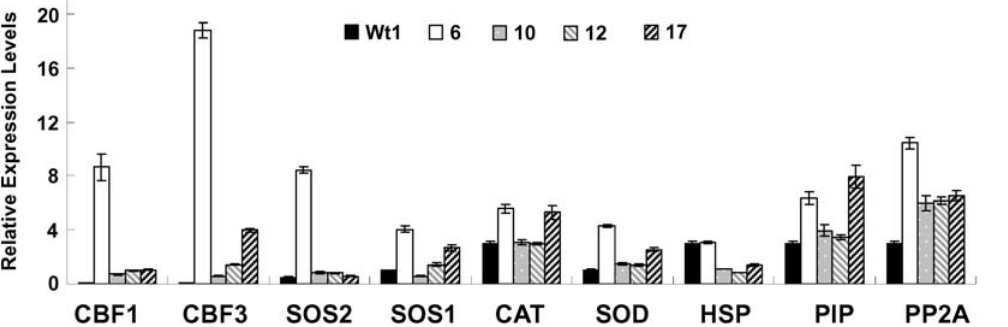
Figure 6. Quantitative RT-PCR analysis of relative expression level of nine selected stress-responsive genes in transgenic and wild- type B.napus plants. Abbreviations: CBF1/CBF3, CBF-like protein; SOS2, serine/threonine protein kinase; SOS1, the plasma membrane Na + /H + antiporter; CAT, catalase; SOD, manganese superoxide dismutase; HSP, heat shock cognate protein Hsc70; PIP, the plasma membrane intrinsic proteins PIPs; and PP2A, phosphatase 1.